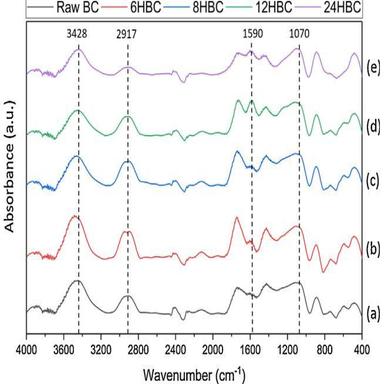
FTIR spectrum of (a) raw BC, and the HBCs heated at 300 C for (b) 6 h, (c) 8 h, (d) 12 h, and (e) 24 h, designated as Raw BC, 6HBC, 8HBC, 12HBC, 24HBC, respectively.